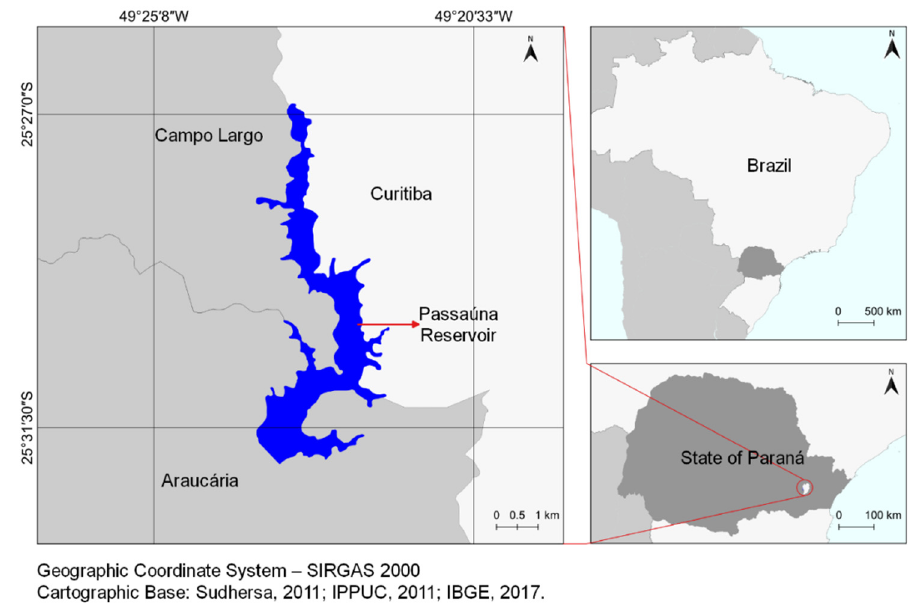
Figure 1. Location of the Passaúna Reservoir. The author.